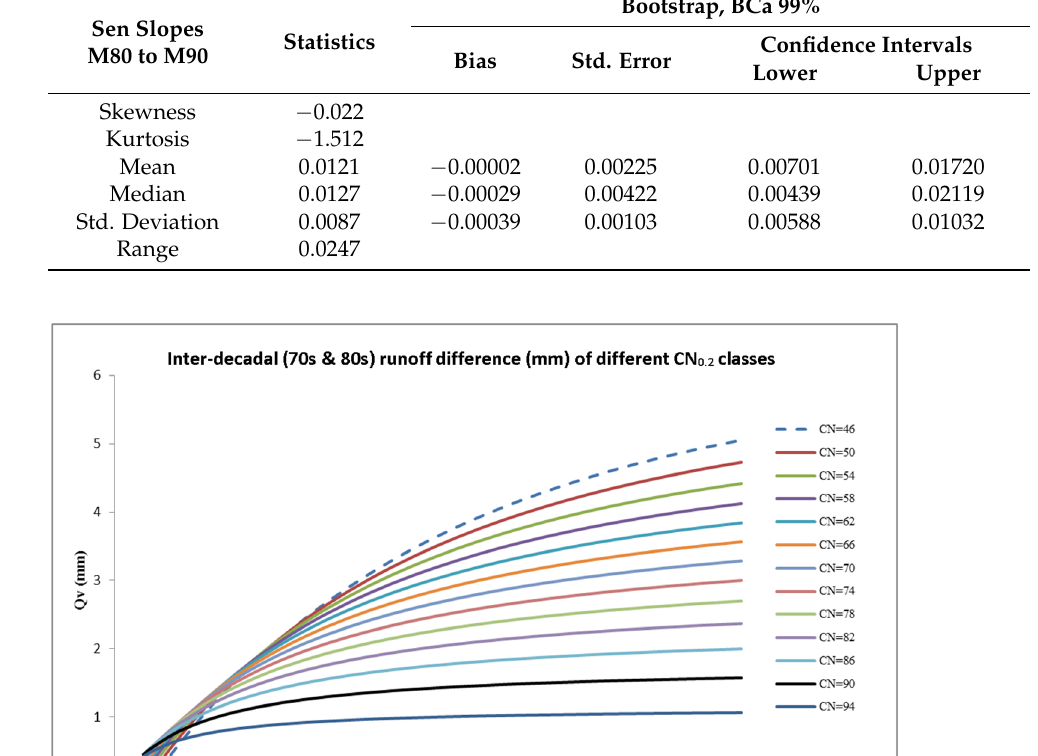
Figure 2. Decadal runo ff di ff erence of Equations (9) and (11) for selected CN 0.2 values to re fl ect the runo ff change between M70 and M90 under di ff erent rainfall depths.